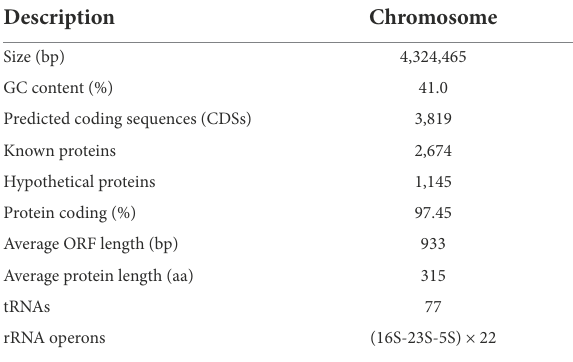
TABLE 4 General features of the P. vermicola P13